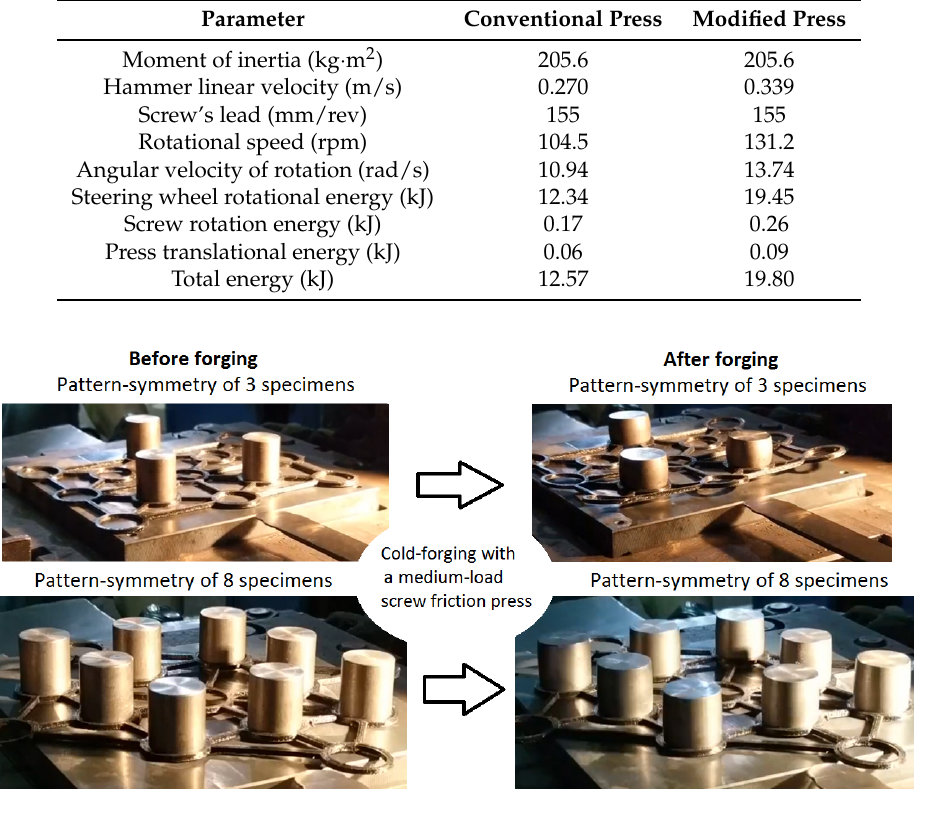
Figure 4. In-situ cold-forging experiments with different pattern-symmetry configurations and specimens quantity.